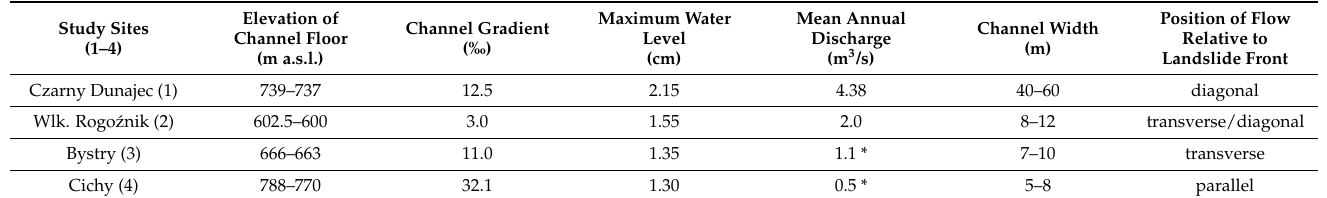
Table 1. Morphological and hydrological parameters of the rivers in studied